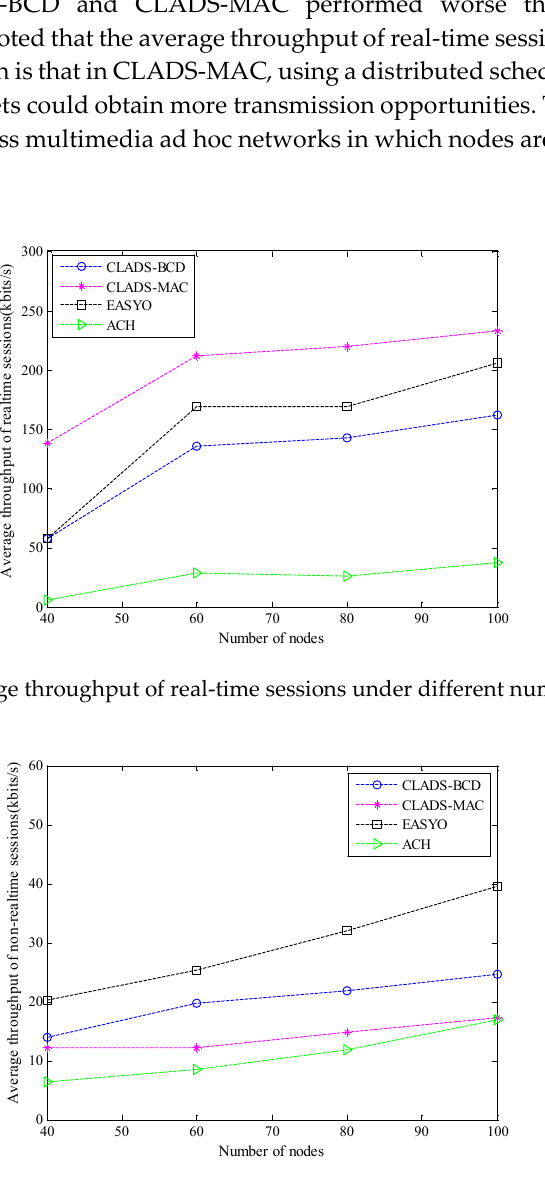
Figure 6. Average throughput of non-real-time sessions under different number of